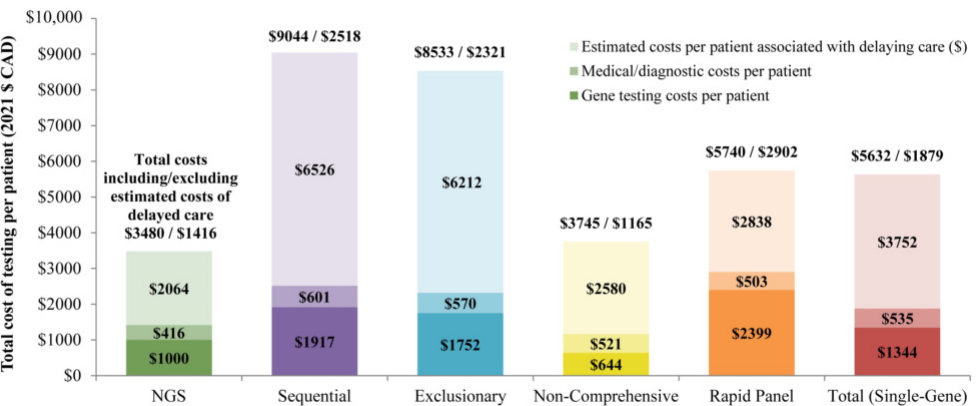
Figure 1. Total cost of testing per patient by strategy, including/excluding estimated costs of delayed